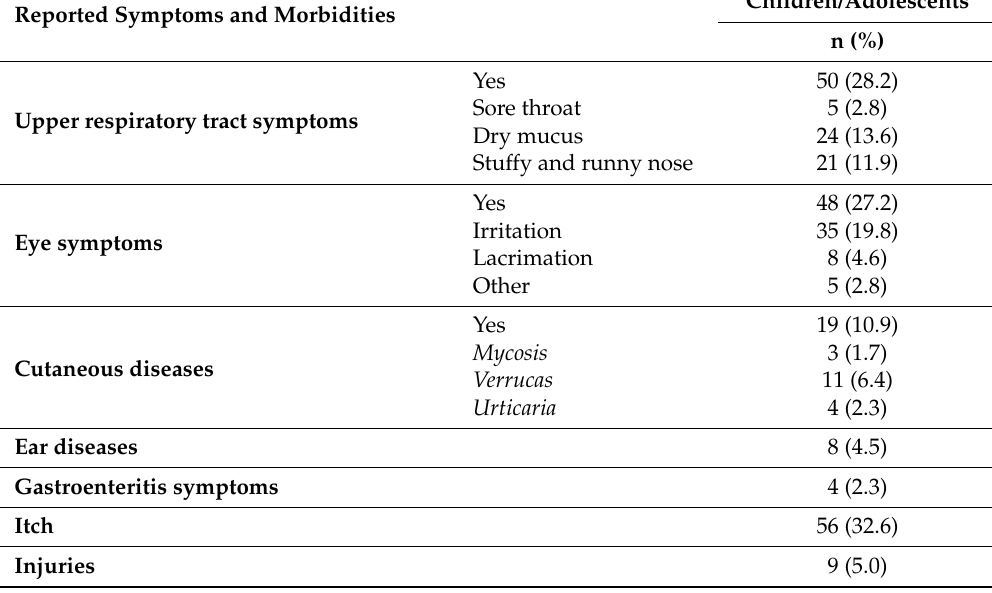
Table 4. Symptoms and morbidities suffered by children/adolescents related to the attendance of swimming pools ( n = 184).